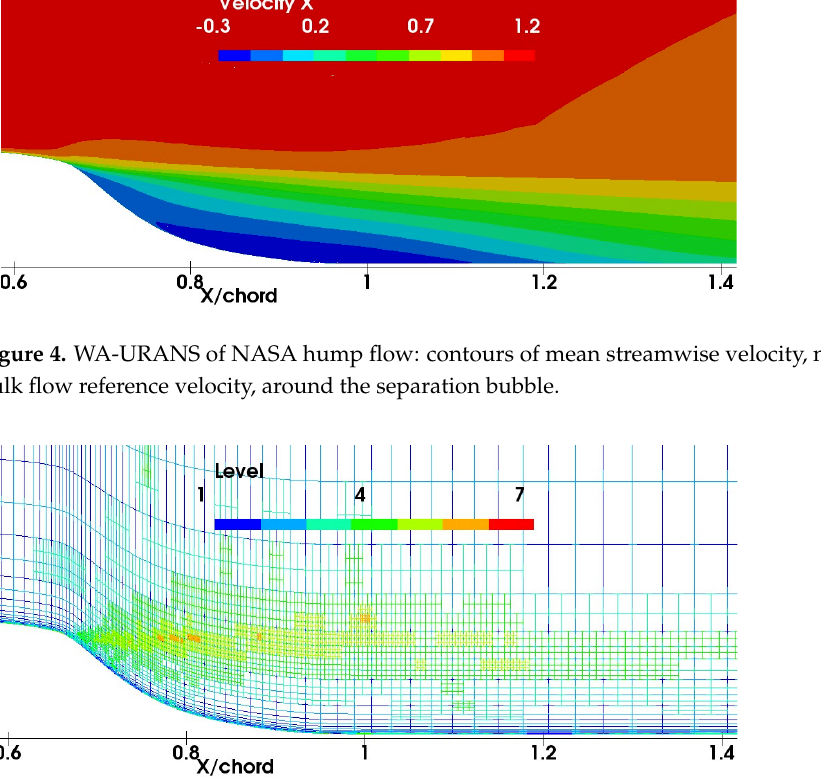
Figure 5. WA-URANS of NASA hump flow: adaptive mesh around the separation bubble. The col- ored contours represent the adaptive mesh resolution